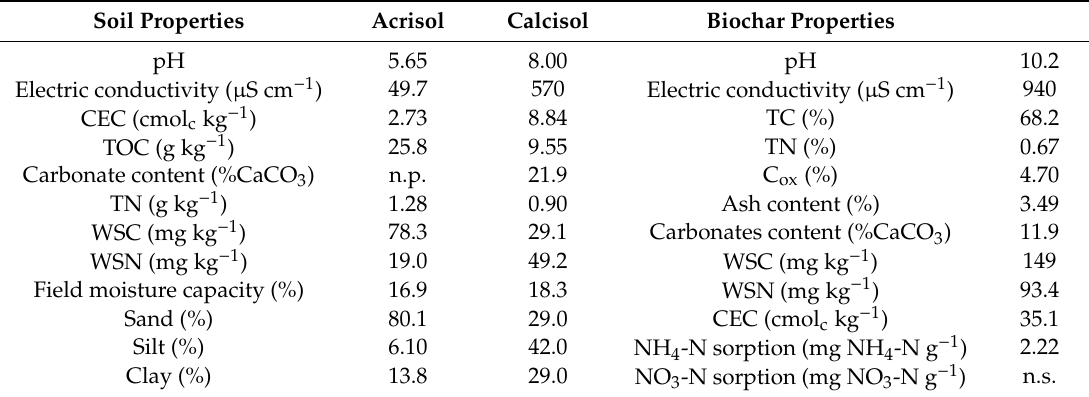
Table 1. Selected soil and biochar